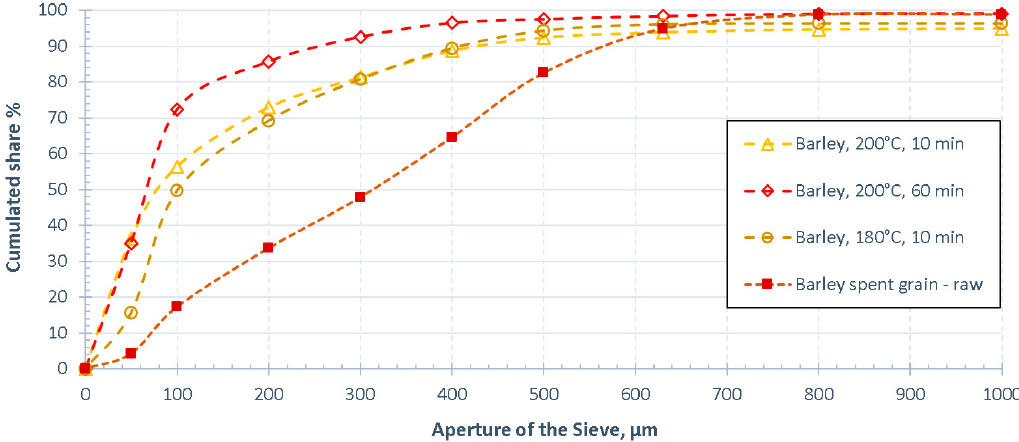
Figure 12. Particle size distribution after grinding spent grain from barley-based beer and respective hydrochars in Retsch SM100 knife mill.